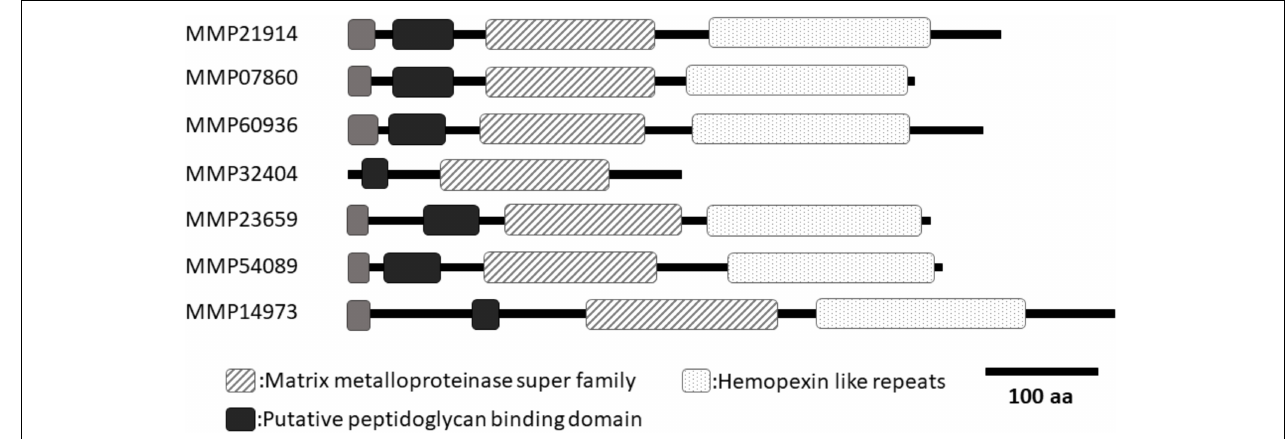
FIGURE 1 | A schematic of the domain structures of seven MMPs from Pinctada fucata . All MMPs, except for MMP32404, had similar lengths and domain structures. Only MMP32404 did not contain hemopexin like repeats in the C-terminal region. Black boxes indicate the putative peptidoglycan-binding domain. Dotted boxes indicate hemopexin-like repeats. Hashed boxes indicate the MMP superfamily domain. Gray boxes indicate the signal peptide. DDBJ accession numbers (MMP21914: LC388937, MMP07860: LC388938, MMP60936: LC388939, MMP32404: LC388940, MMP23659: LC388941, MMP54089: LC388942, MMP14973: LC388943).